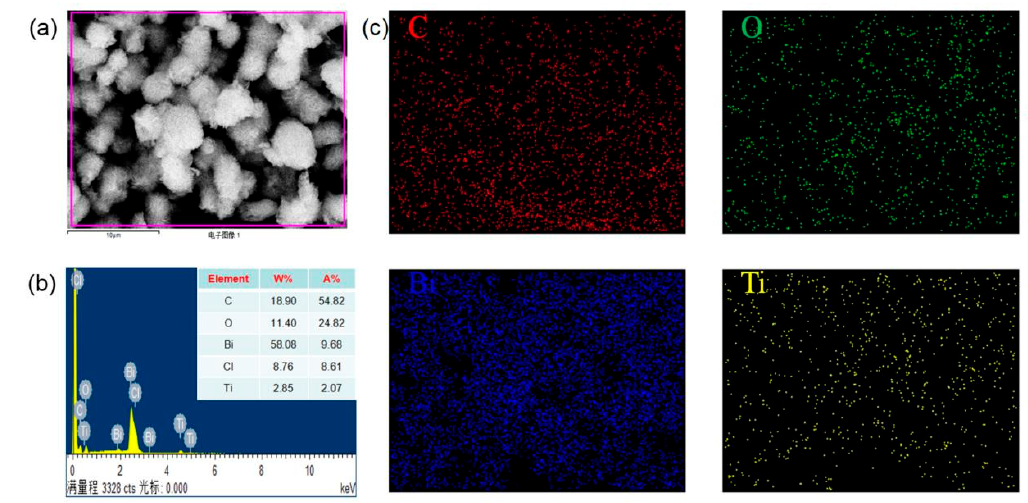
Figure 4. ( a ) Representative SEM image, ( b ) EDX spectrum, and ( c ) elemental mapping of RGO/BiOCl/TiO 2 nanocomposites with 10% of TiO 2 .